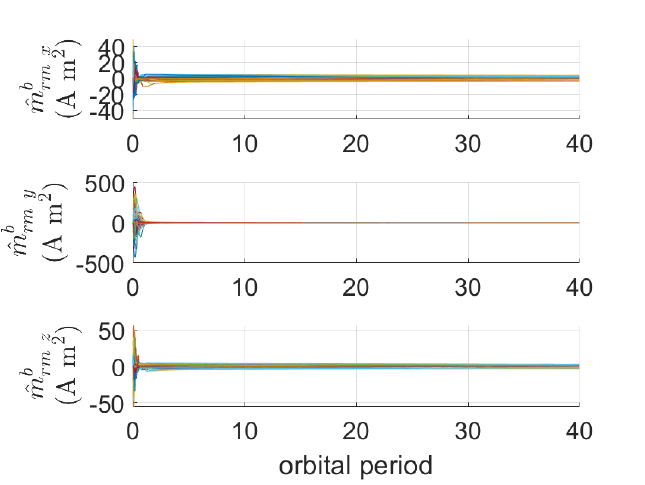
Figure A1. Time histories of ˆ m b rm obtained in the Monte Carlo campaign for the perturbed case using rotation matrix